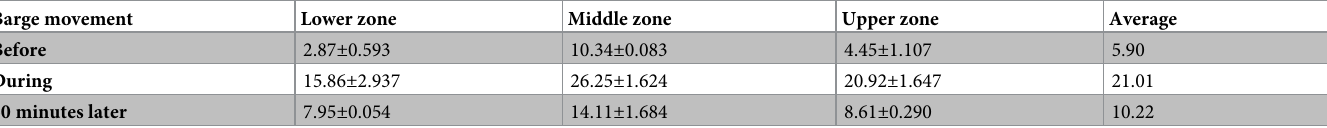
mechanism of those marine/ brackish water phytoplankton species of that are being trans- ported to this zone by tidal ingress [61] and abrupt creation of turbulence in the transporting Table 4. Percentage of damaged cell (Mean ± SD) in three zones at different time interval of barge passage. Barge